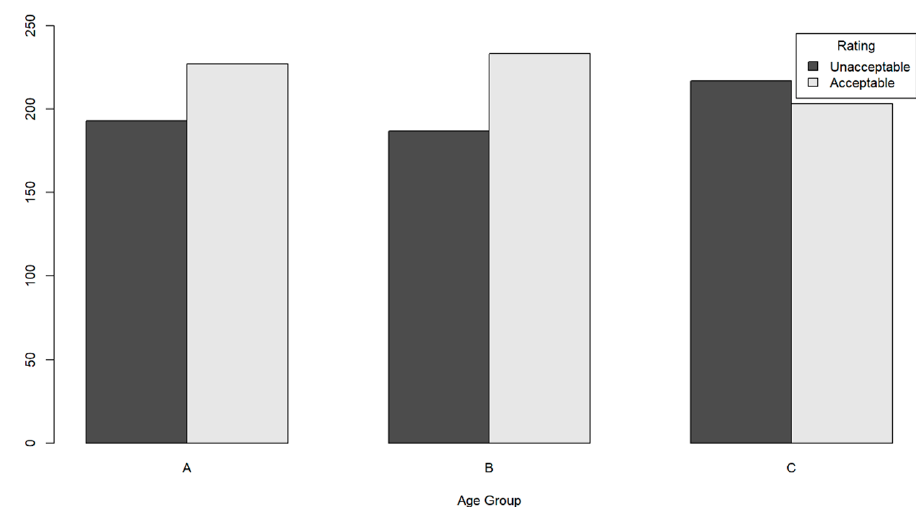
Figure 3. (Un)acceptability rate of the indefinite determiners in the age groups.